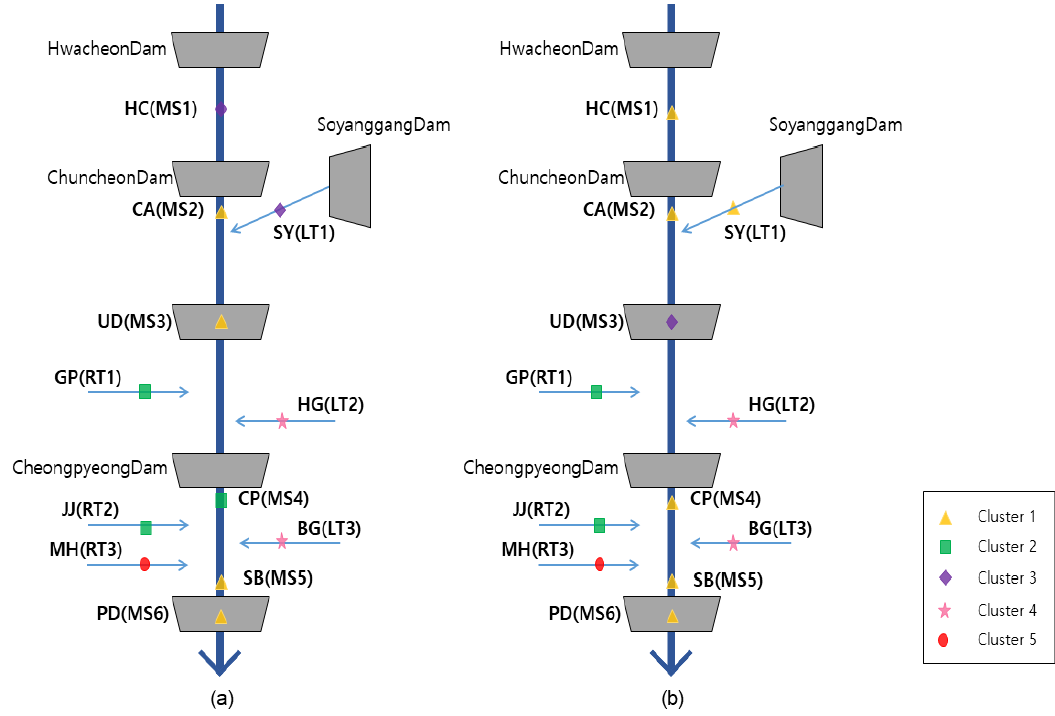
Figure 5. Cluster formation using the ( a ) Euclidean algorithm and ( b ) Dynamic Time Warping (DTW) algorithm.